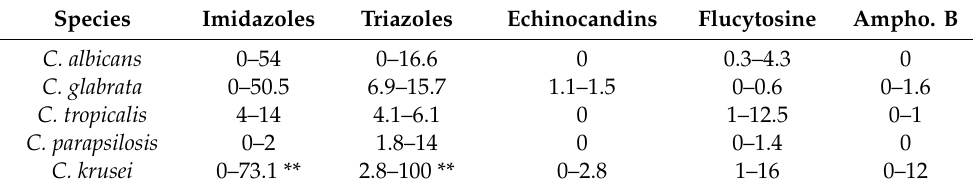
Table2. Percentageofisolatesamongthefivemoreprevalent Candida spp. exhibitingresistancetoazoles, echinocandins, flucytosine or amphotericin B (amphoB), as reported by surveillance epidemiological studies [22,32–39]. ** The high range of percentages found for C. krusei results from this species showing highly divergent susceptibilities to di ff erent imidazoles or triazoles (e.g., most strains are largely resistant to fluconazole but susceptible to